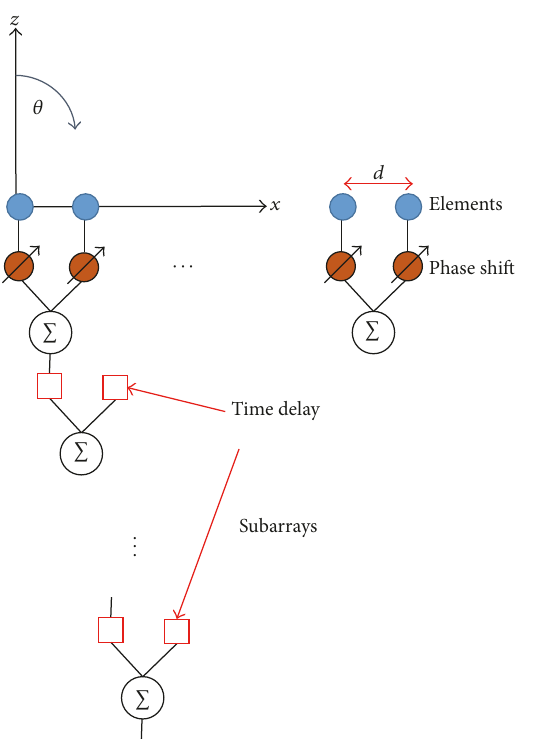
Figure 12: Time delay is typically placed at the subarray